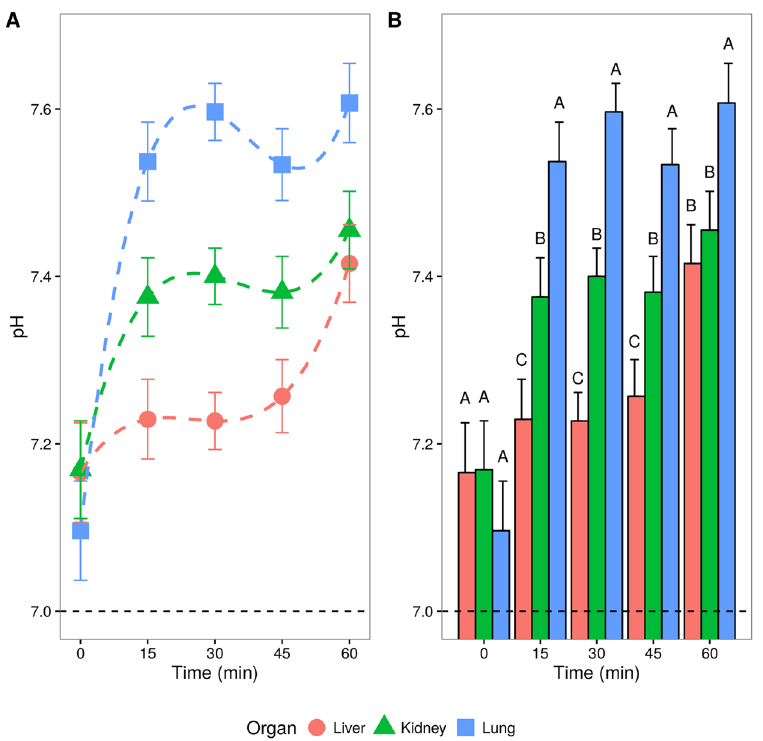
Figure 1. pH variation according to ischemia time evolution in three different organs. ( A ) Organs third-degree adjusted time polynomial linear mixed model results (dashed lines). ( B ) Fisher’s least significant difference between organs mean at each data point. Superscript letters indicate significant difference (p < 0.05) using Bonferroni adjusted p-values. In both panels results are presented as mean ± standard error